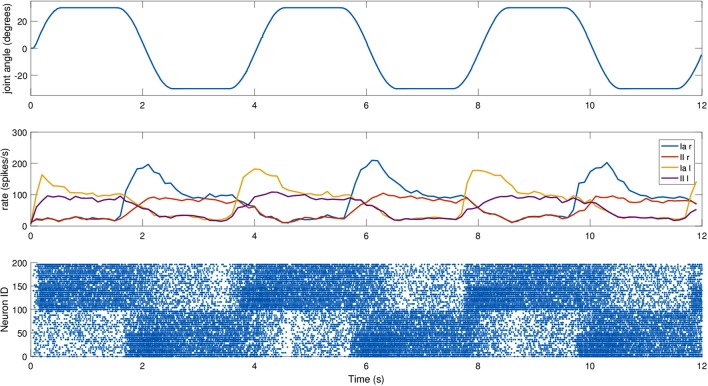
Afferent activity for the neck muscle pair simulated on the iCub robotic platform. The head motion during the trial is on top, computed rates for Ia and II activities are shown in the middle, and the raster plot for the two muscle populations is on the bottom. To improve visibility in the raster plot, only activity of 25% of the units of the spindle populations is displayed.